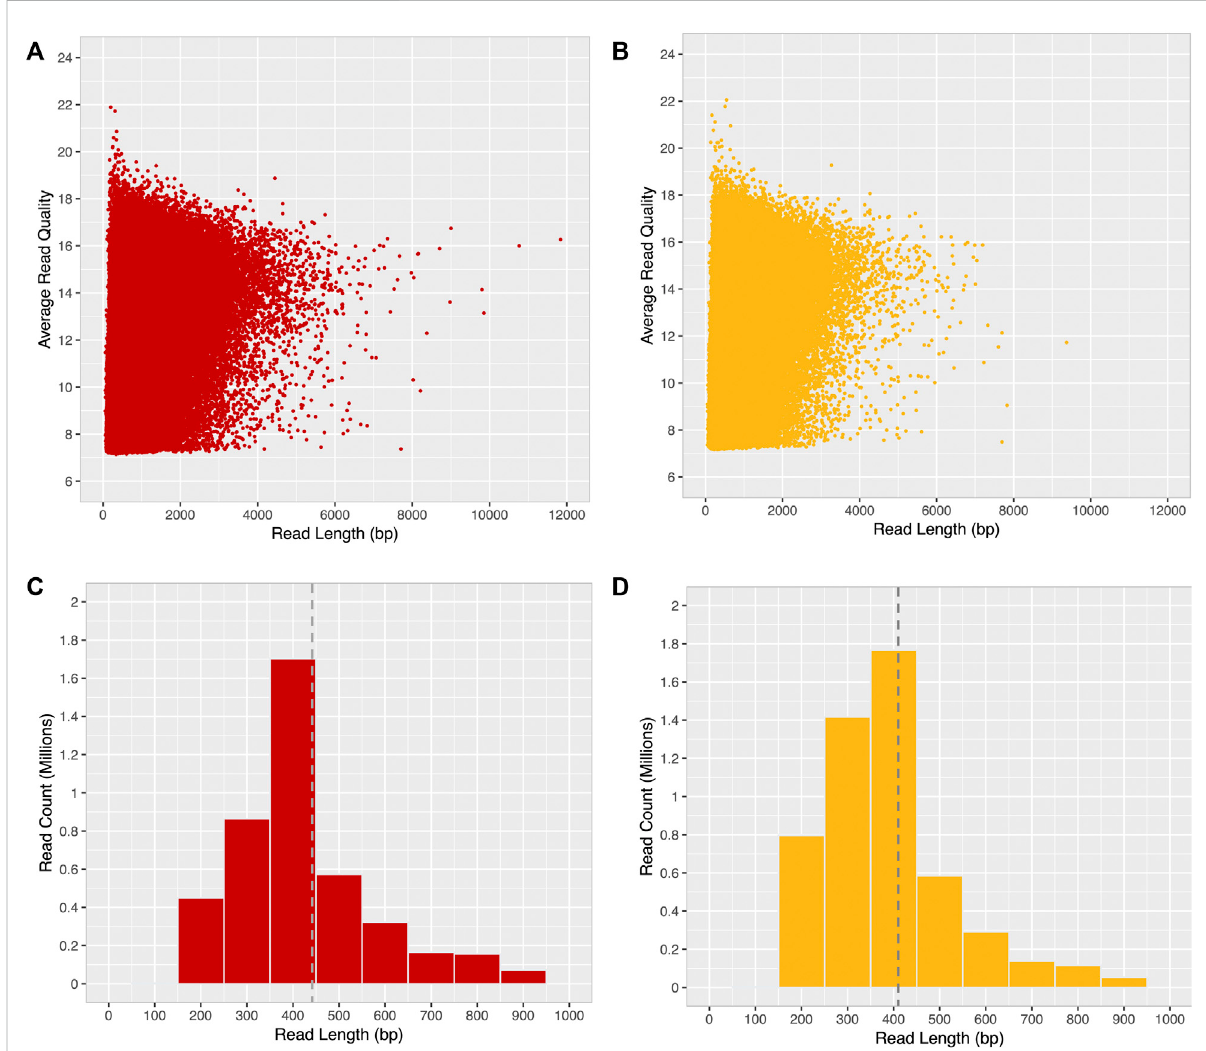
FIGURE 3 Readquality andreadlengthdistributionof fi lteredONTlong-reads.Afteraminimumbasequalitycut-offof7,amajorityoflong-readsforboth samples (A) ONT-1,and (B) ONT-2werewithinthe4 kbprange,withanaveragebasequality ≤ 19.Mostlong-readswere400 bpinlengthforboth (C) ONT-1, and (D) ONT-2, with N50 values of 448 bp and 407 bp represented as grey dotted